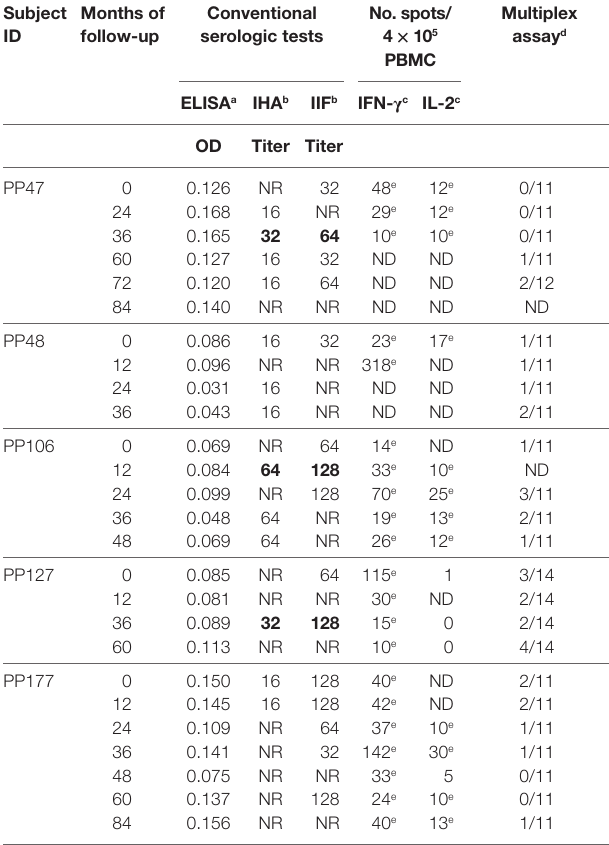
TaBle 2 | Humoral and T-cell responses to T. cruzi antigens in subjects with discordant conventional